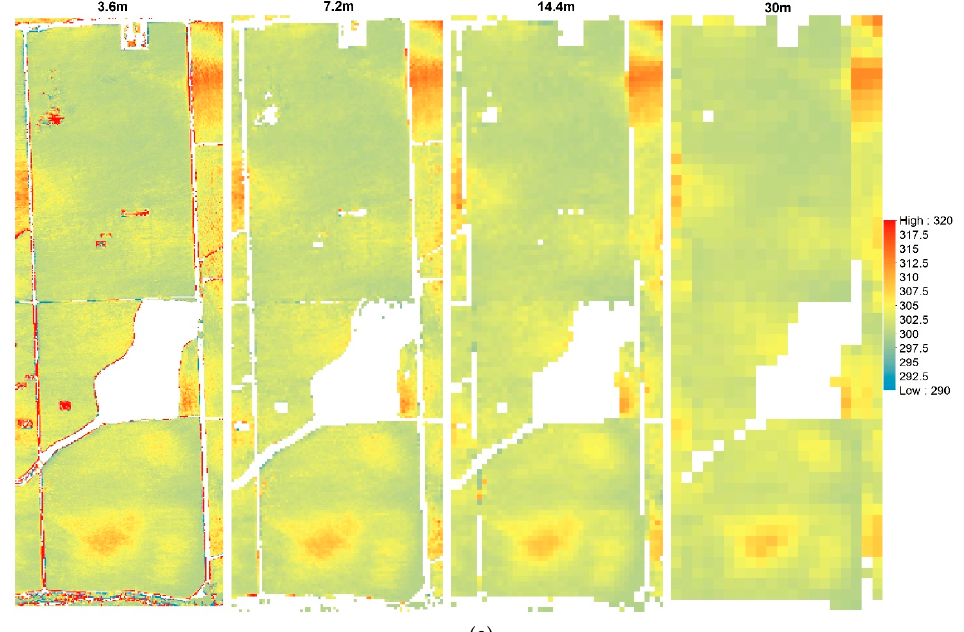
Figure 7. The LST-NDVI relationship used for finding T c and T s as proposed by the TSEB2T model at di ff erent spatial domains (09 August 2014). ( a ) 3.6 m, ( b ) 7.2 m, ( c ) 14.4 m, ( d ) 30 m.